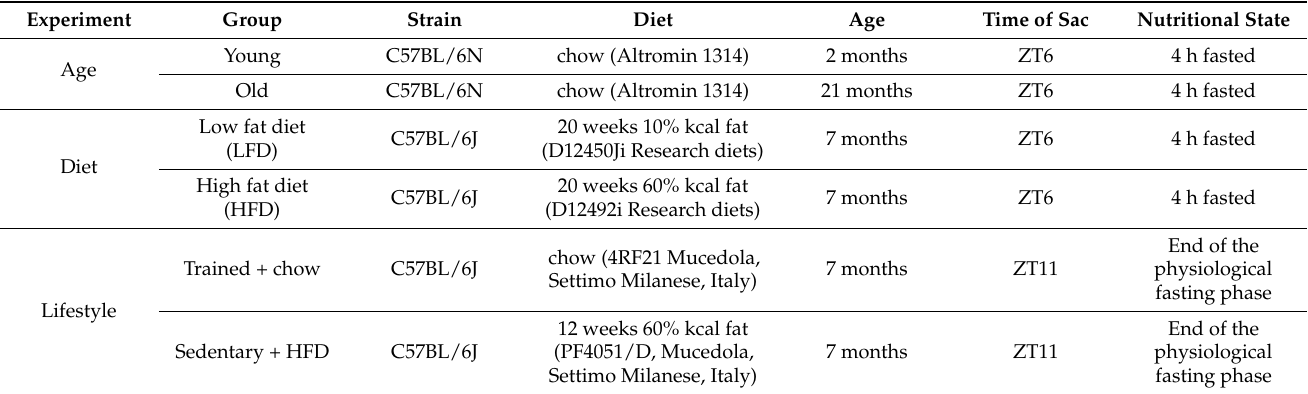
Table 1. Details of experimental